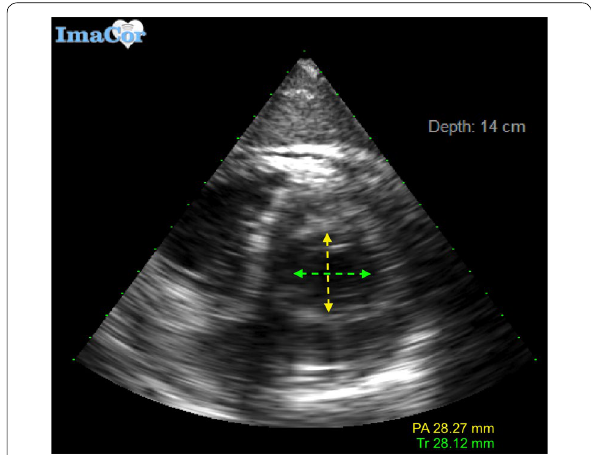
Fig. 2 Transesophageal echocardiographic view demonstrating transverse and posteroanterior measurements of left ventricle in end‑systole